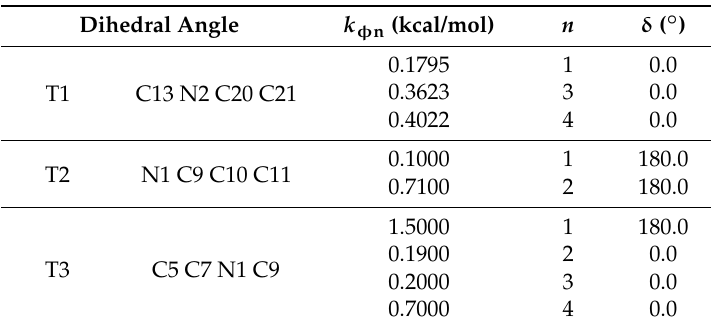
Table 2. Parameters of the torsional rotations T1, T2, and T3 for the GQ16 molecule determined by fitting the potential energy curves shown in Figure 3.